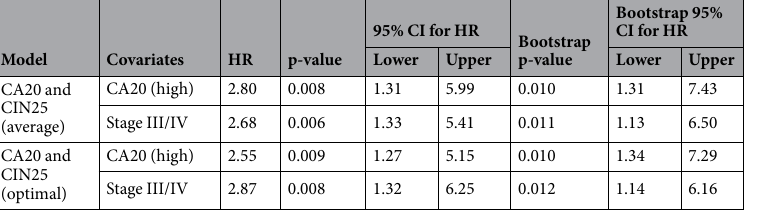
Table 5. Final multivariable Cox proportional-hazards models of overall survival including CA20 and CIN25 (based on average or optimal thresholds) and AJCC stage in full models using TCGA data along with p-values and 95% confidence intervals (CIs) for final model covariate hazard ratios obtained via simple bootstrapping. References for hazard ratios (HRs) are CA20 (low) and stage I/II.